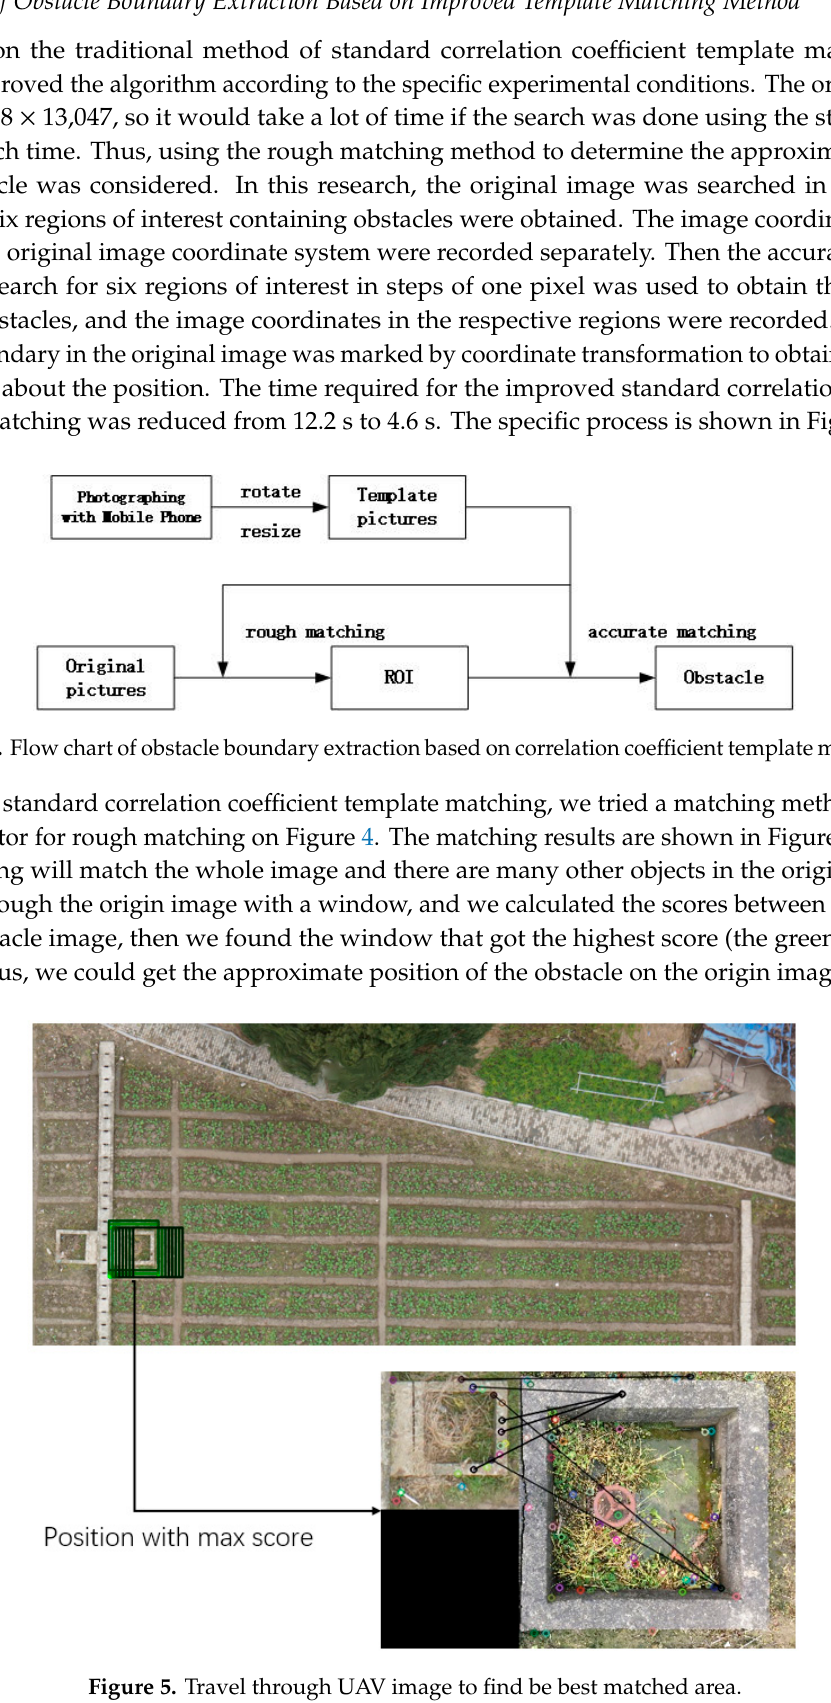
Figure 3. Obstacle number and corner sequence.